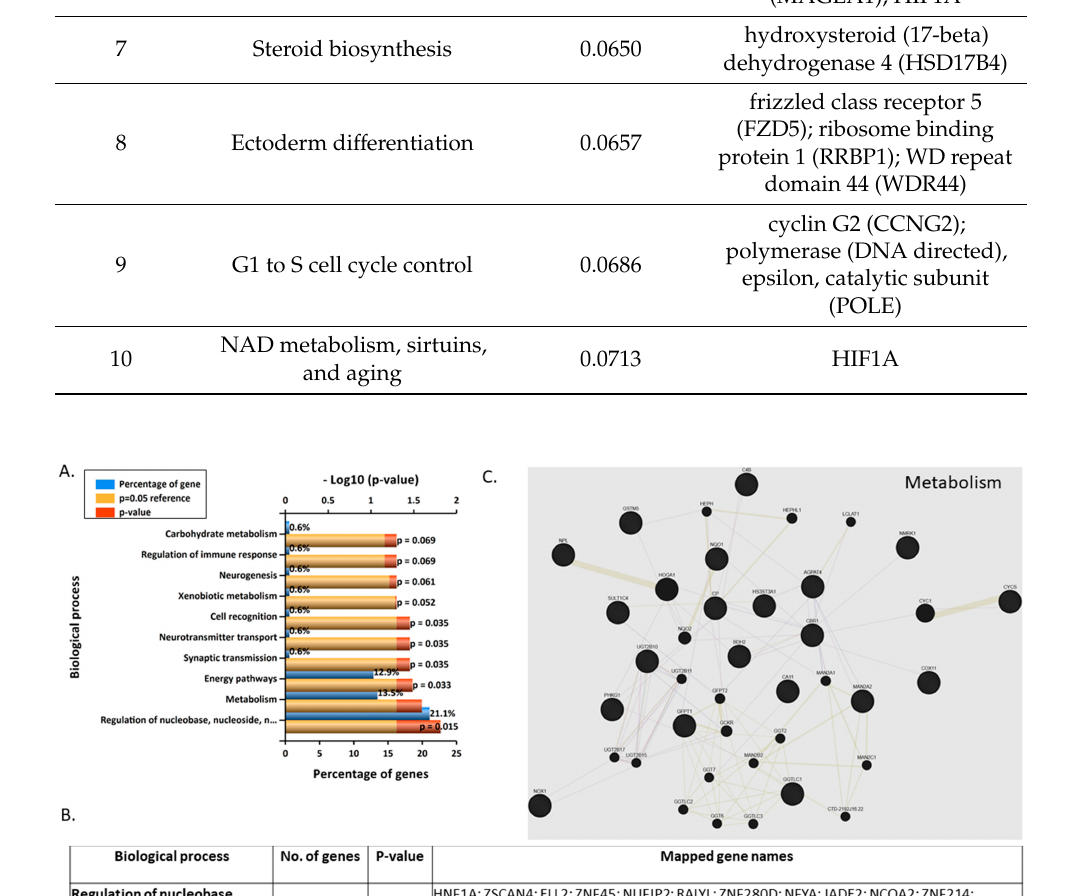
Figure 7. ( A )Top 10 enriched (Funrich) biological processes for 10 nM BPA-treated syncytialised BeWos. ( B ) Table of genes involved in transport and protein metabolism.: exportin 6 (XPO6), solute carrier family 20 member 2 (SLC20A2), Sec61 translocon gamma subunit (SEC61G), solute carrier family 25 member 40 (SLC25A40), WD repeat domain 44 (WDR44), ribosome binding protein 1